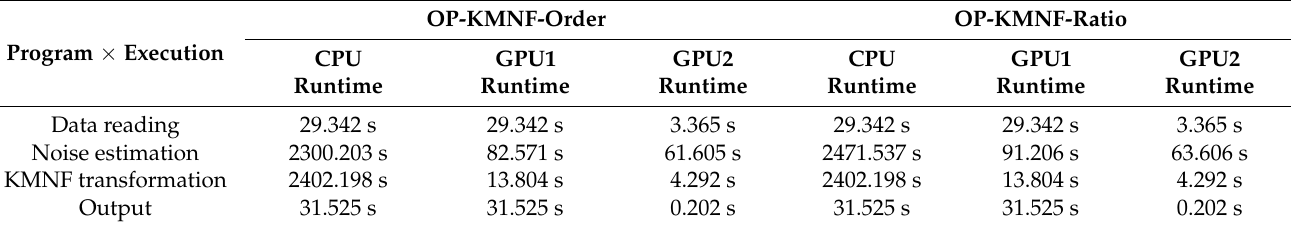
Table 10. The computational costs of OP-KMNF when the data volume is 400 × 400 ×